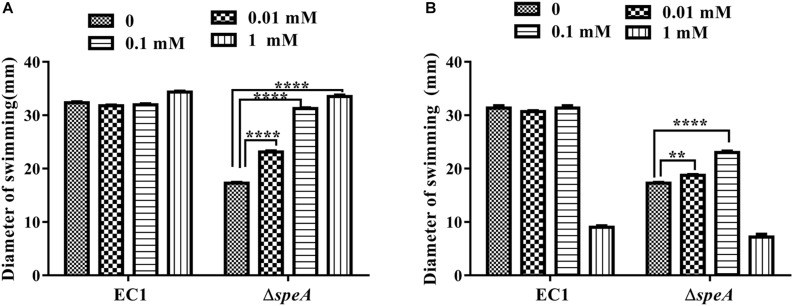
Effect of exogenous addition of polyamines on bacterial swimming motility. Bacterial strains were grown under the same condition but supplemented with different concentrations of putrescine (A) and spermidine (B). The diameters of swimming motility were measured after incubation for 24 h at 28°C. The data shown are the means ± SE (n = 3). ****P < 0.0001, ∗∗P < 0.01.